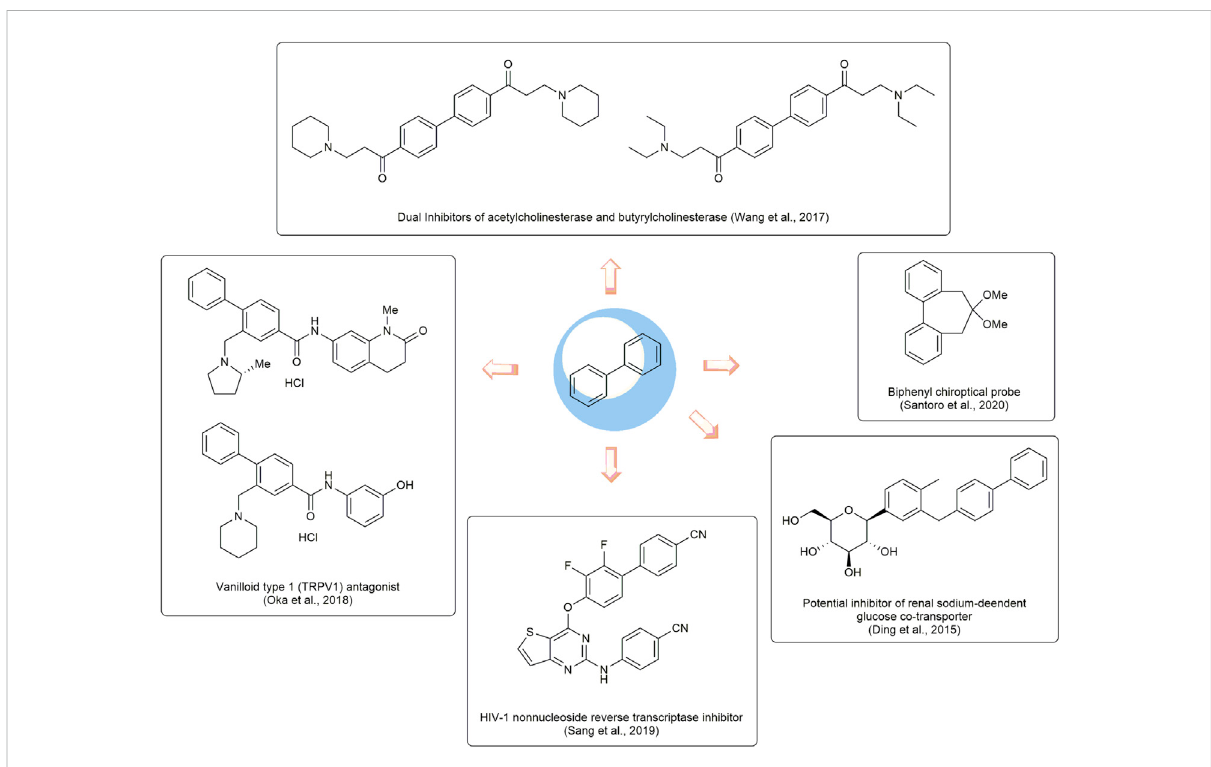
FIGURE 2 Development of bioactive compounds based on